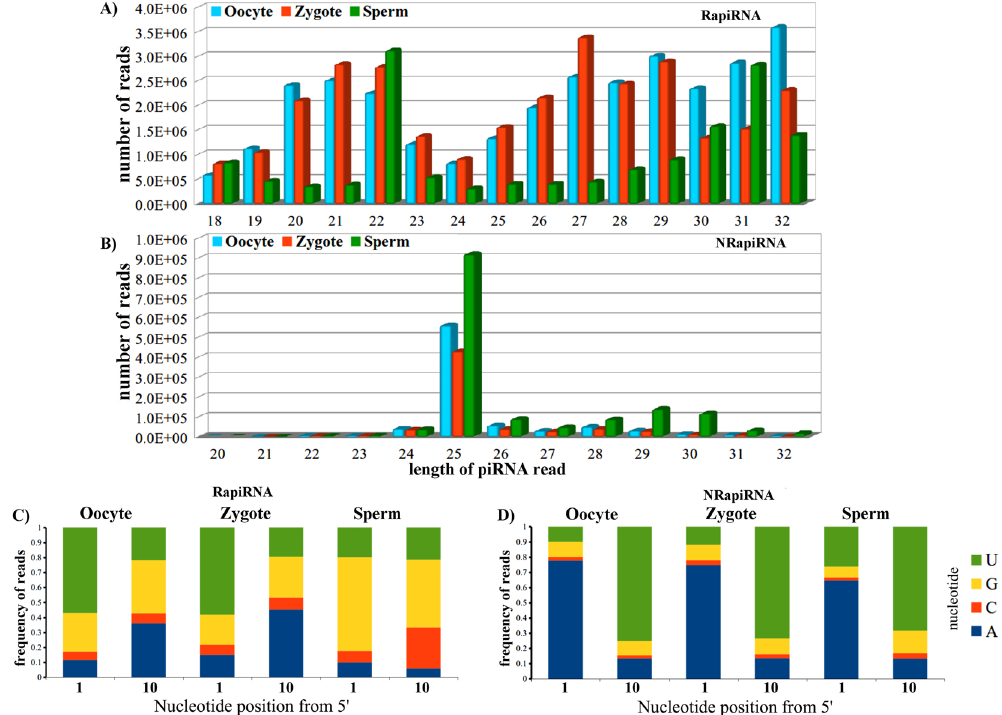
Figure 1. Lengths and nucleotide distributions of piRNAs associated and not associated with repeated elements. Panels A and B show the length distributions of piRNAs. C and D, the nucleotide frequencies of the first (1) and tenth (10) positions of the piRNA populations. Panels A and C are related to the piRNA population associated with TEs (RapiRNAs). Panels B and D are related to the piRNA population not mapping to TEs